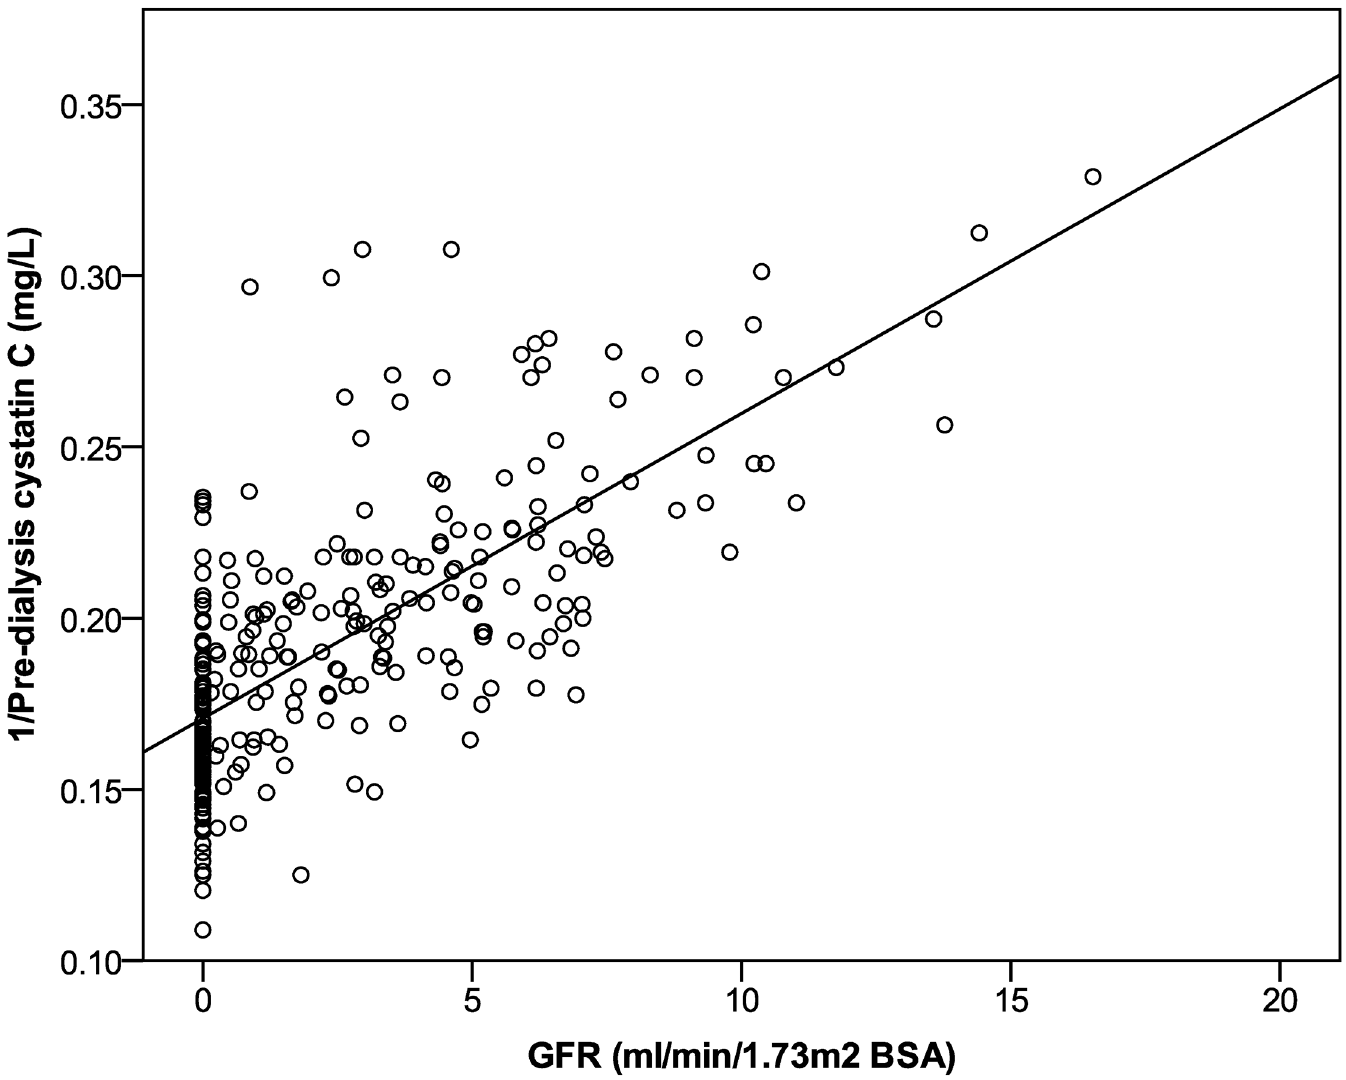
Fig 2. Relationship of GFR with the reciprocal of pre-dialysis plasma Cystatin C levels. GFR shown is calculated from the mean of urea and creatinine clearance. For the linear regression shown r 2 was